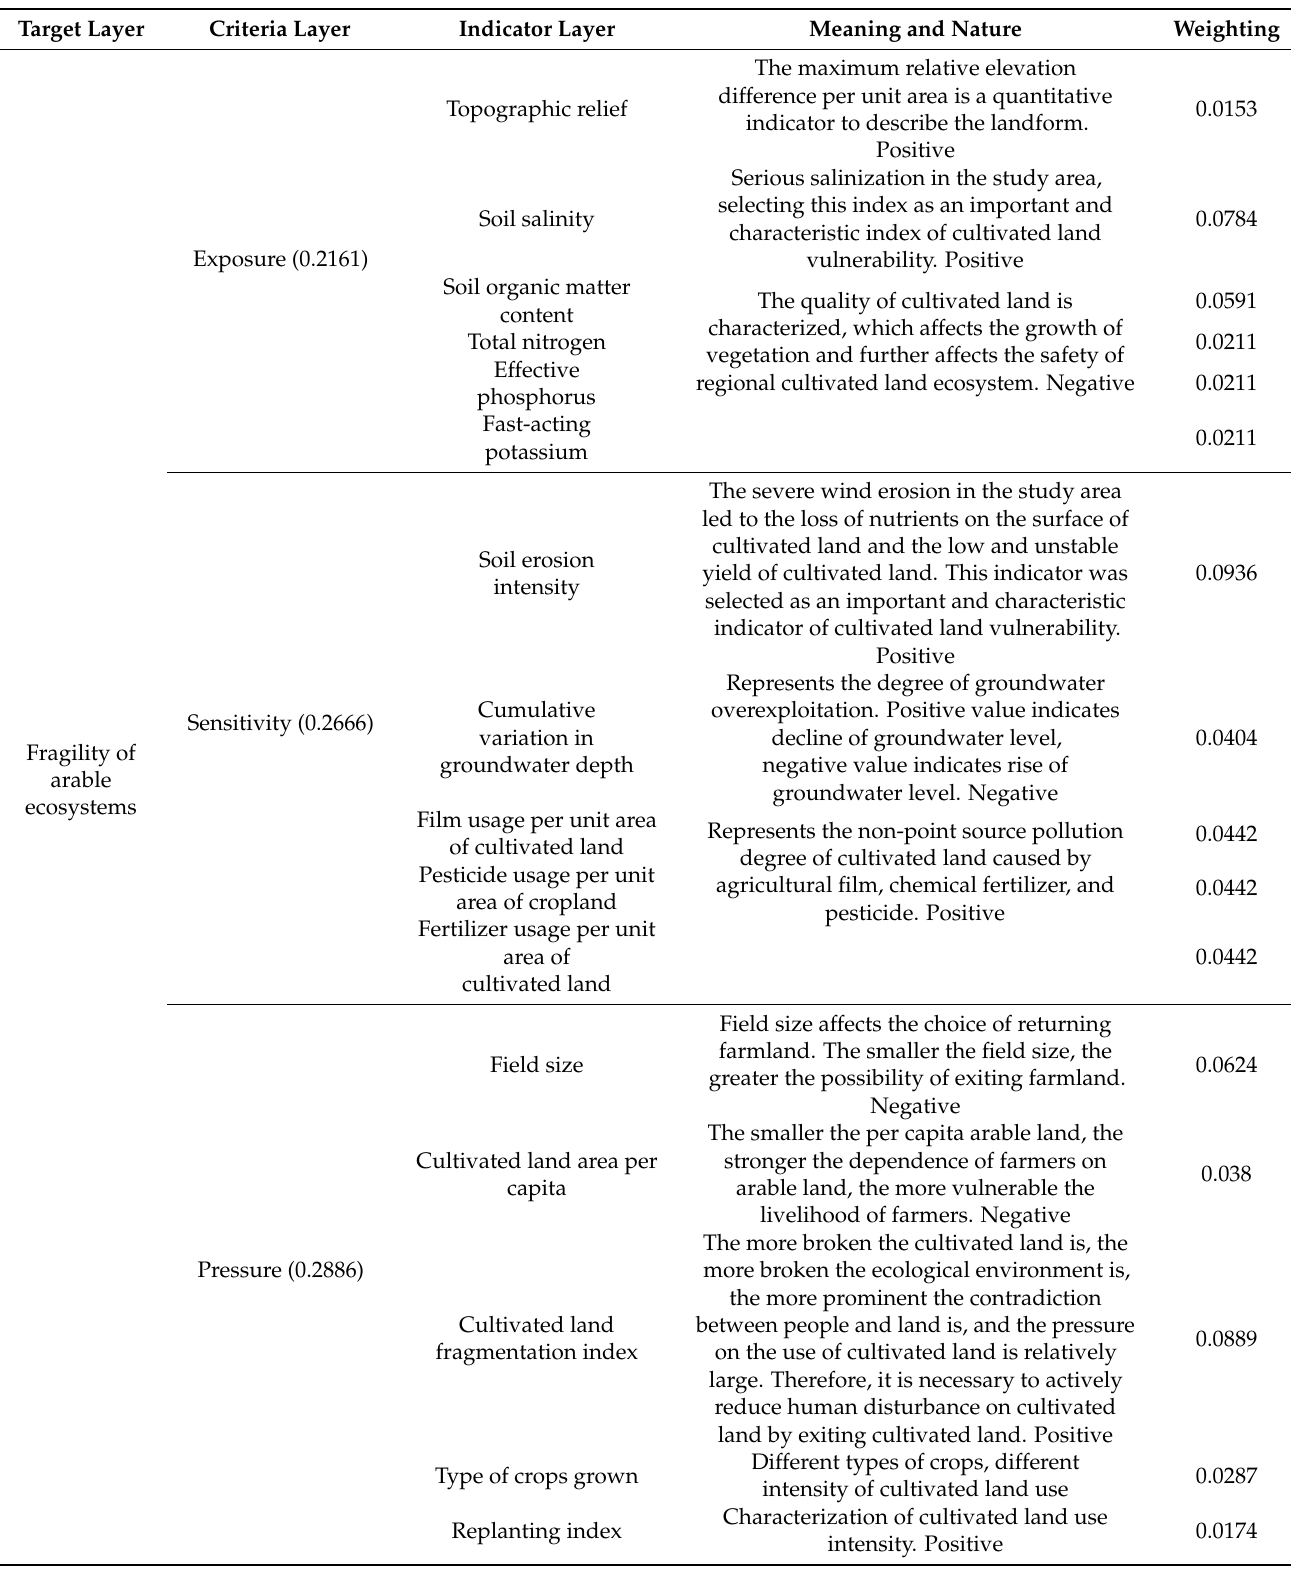
Table 1. Evaluation Index System of Cultivated Land